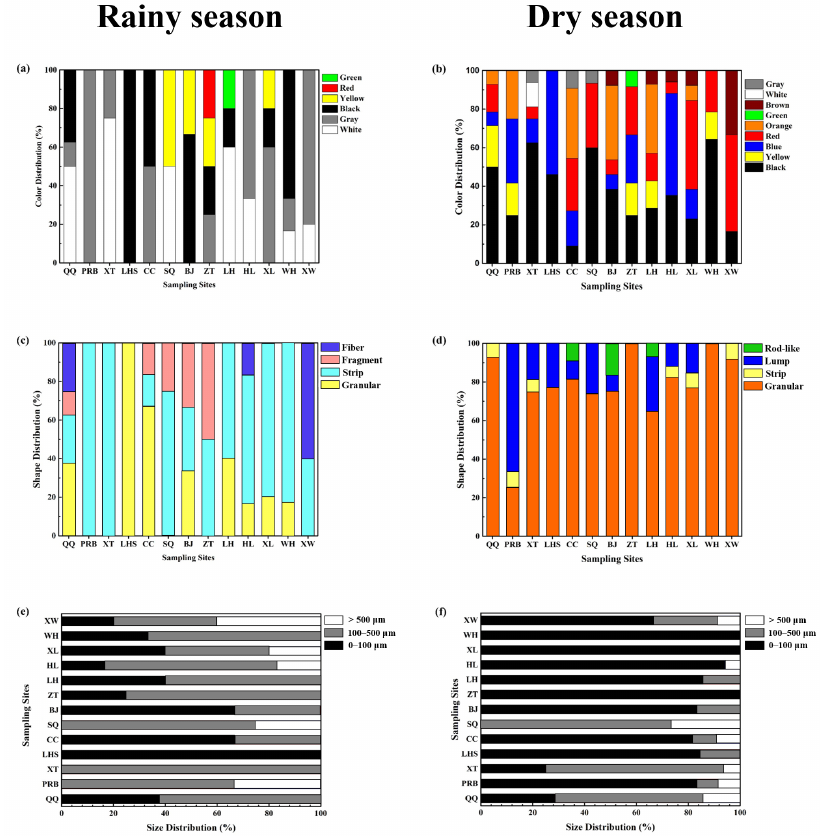
Figure 4. Color, shape, and size distribution of microplastics in the surface water samples at different sampling sites in the Pearl River Delta. ( a , b ) color compositions during the rainy and dry seasons; ( c , d ) shape compositions during the rainy and dry seasons; ( e , f ) size distributions during the rainy and dry seasons. Note: QQ, Qingqi; PRB, Pearl River Bridge; XT, Xiaotang; LHS, Lianhuashan; CC, Chencun; SQ, Shiqiao; BJ, Beijiao; ZT, Zuotan; LH, Lanhe; HL, Hengli; XL, Xiaolan; WH, Waihai; XW, Xinwei.